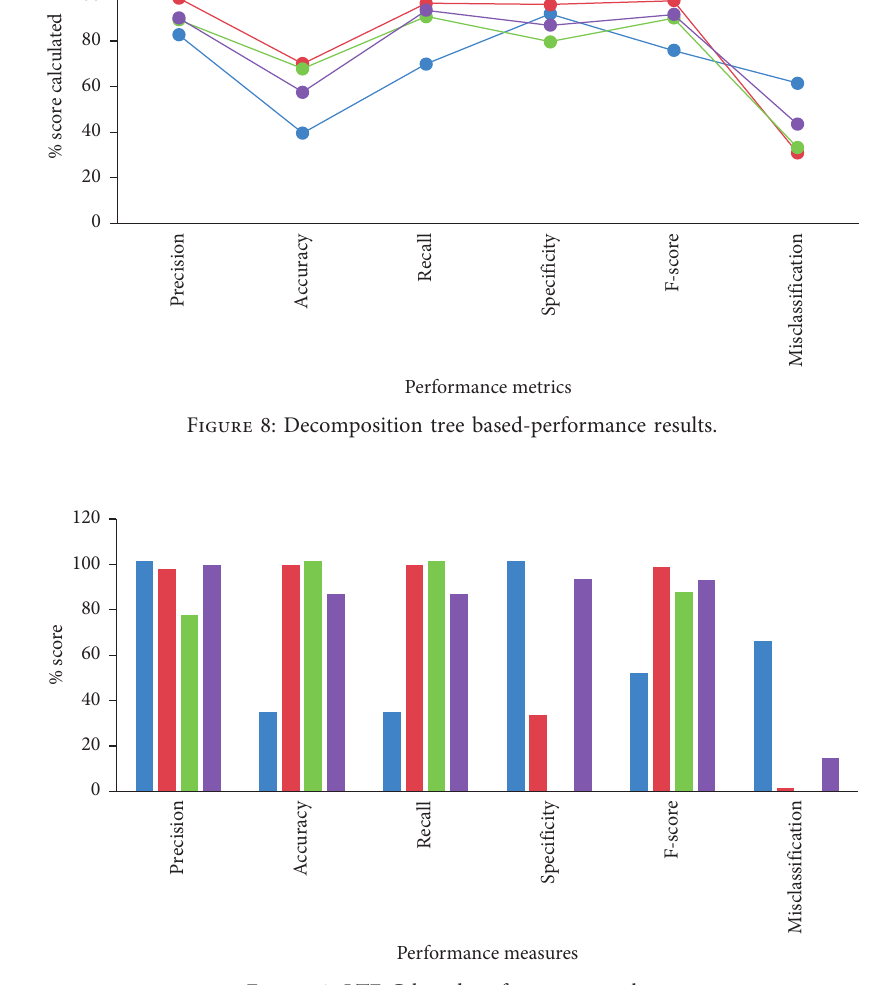
Figure 9: LTF-C-based performance